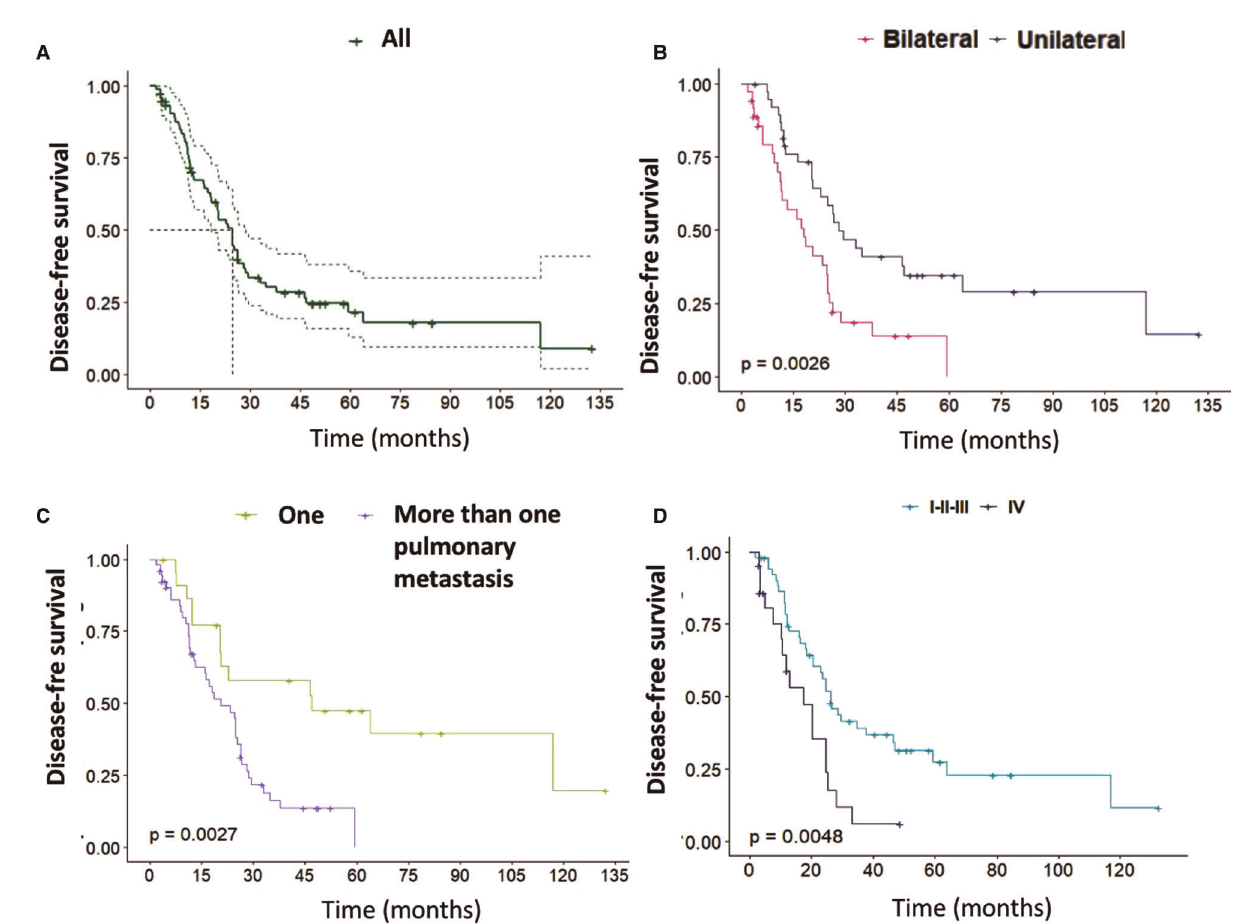
FIGURE 2 | ( A ) Disease-free survival (DFS). ( B ) DFS of patients with unilateral and bilateral metastases. ( C ) DFS according to the number of pulmonary metastases. ( D ) DFS according to the stage at diagnosis. Kaplan-Meier curves with the log-rank